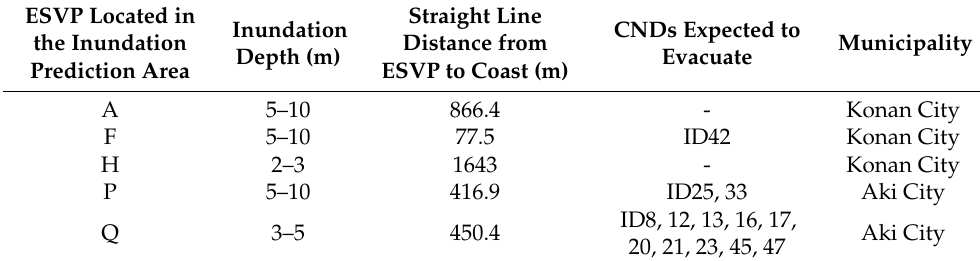
Table 2. Characteristics of ESVPs in the predicted inundation